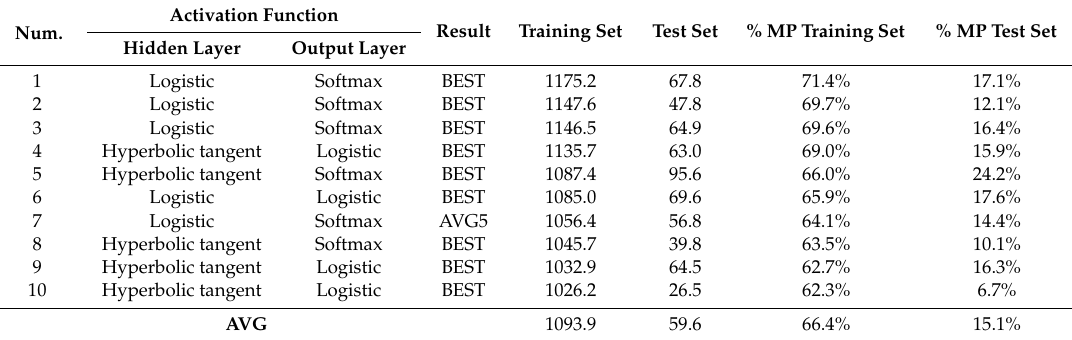
Table 7. Top 10 SANN results (in USD/b).